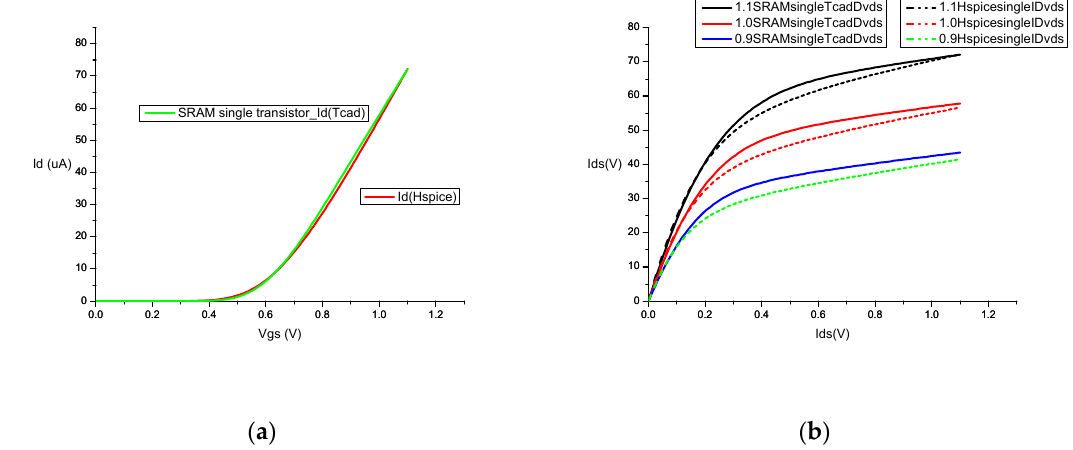
Figure 2. A single transistor of a static random access memory (SRAM) cell: ( a ) I d –V g curves calibrated, ( b ) I d –V d curves calibrated.